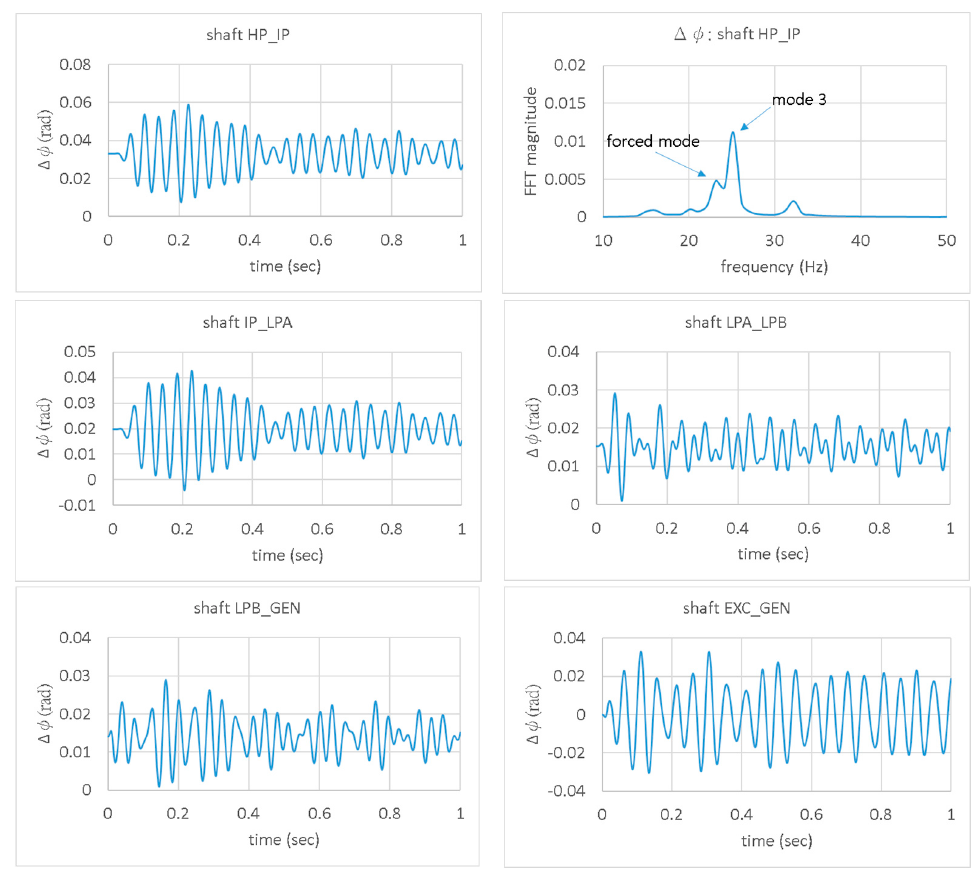
Figure 5. Torsional vibrations under the normal situation.